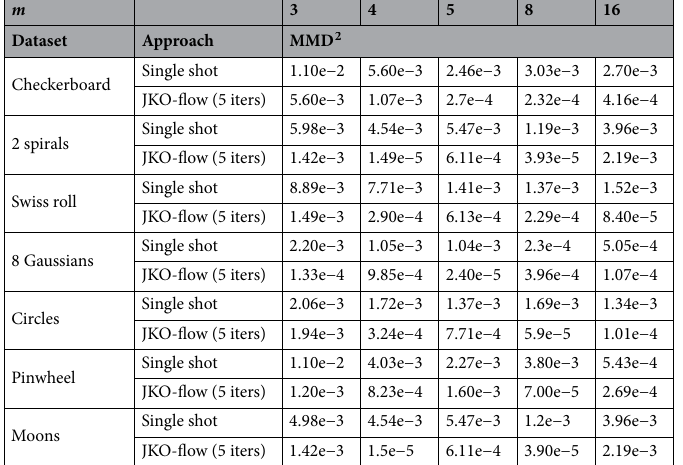
Table 2. Synthetic 2D data: network width comparison for 1 and 5 iterations given a fixed, best performing α . JKO-Flow performs better than the single shot approach for different network sizes.